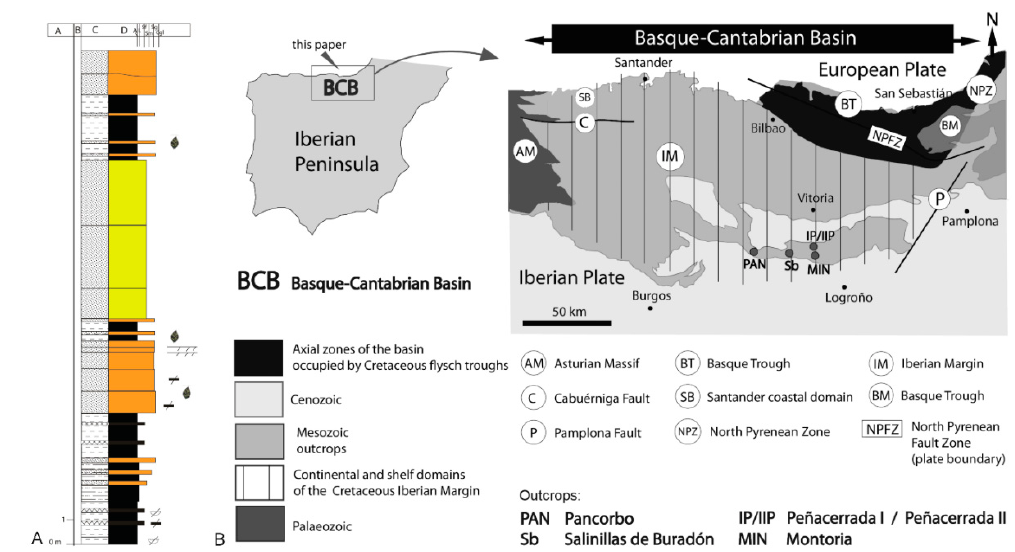
Figure 1. ( A ) Stratigraphic profile of the Peñacerrada I outcrop after [13], modified. ( B ) Geographical and geological setting with location of the studied section after [15] modified.